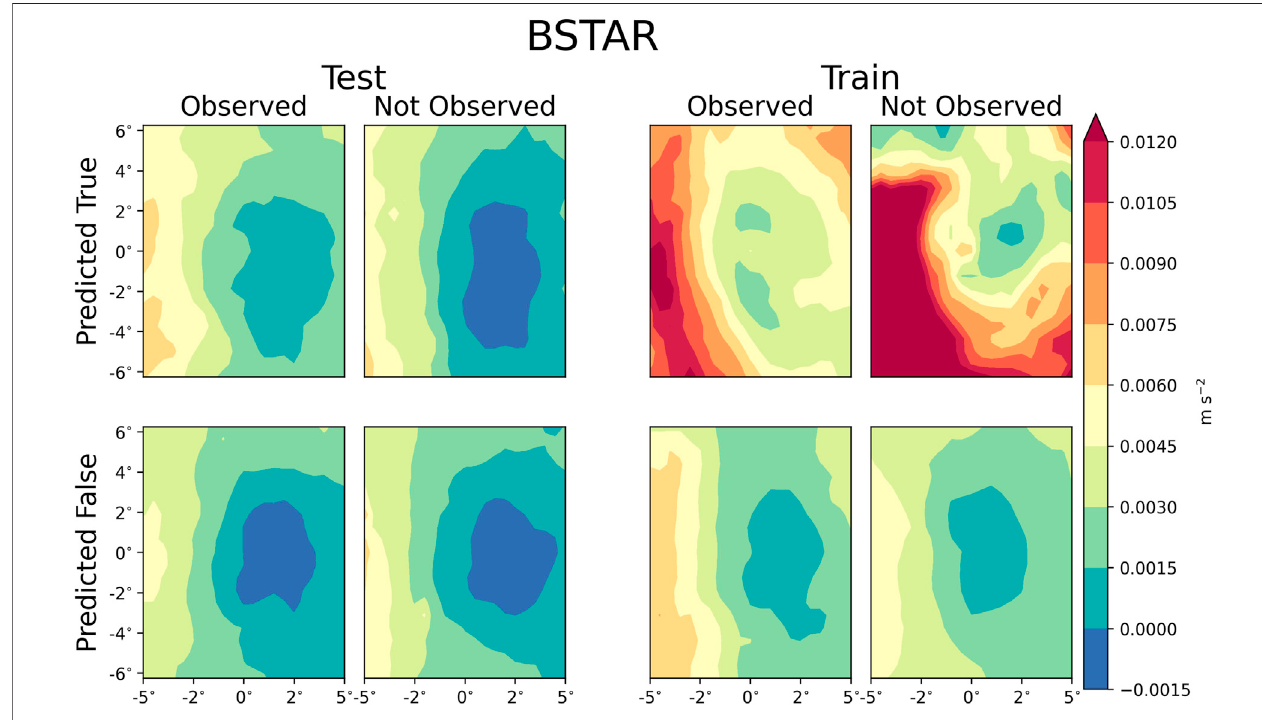
FIGURE 5 | Composite mean of the surface buoyancy scale (BSTAR).